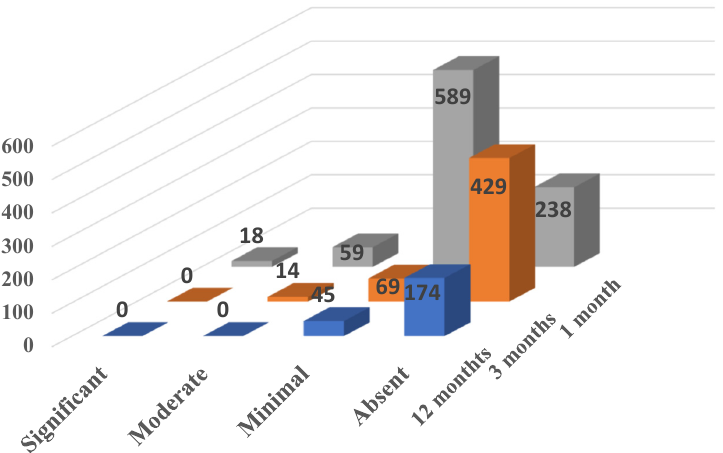
Scheme 4. The effect of PAE on dysfunctional metrorrhagia in patients diagnosed with uterine fi- broids.